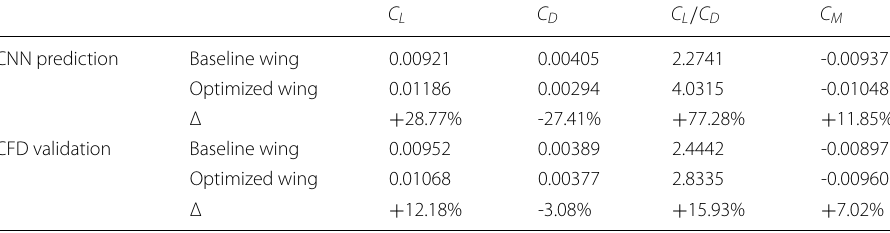
Table 10 Comparison of aerodynamic performance obtained from the CNN prediction and the CFD validation for the baseline and optimized wings (optimization case 1) C L C D C L / C D C M CNN prediction Baseline